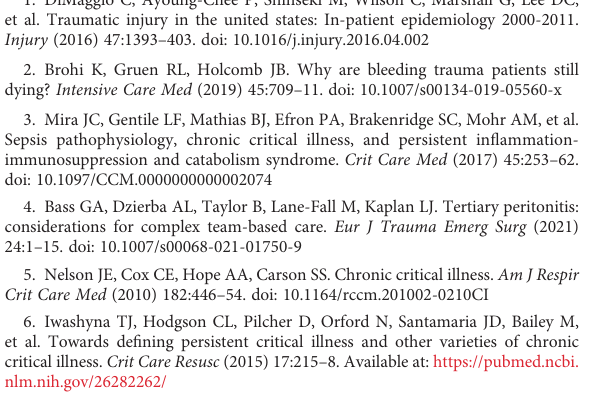
SUPPLEMENTARY FIGURE 2 Selection of model predictors using the least absolute shrinkage and selection operator (LASSO) logistic regression model combined with 10- fold cross-validation. ( A ) Selection of appropriate parameters ( l ) from the LASSO method by ten-fold cross-validation and minimum criteria. Binomial deviance curve was plotted against log ( l ). Dotted vertical lines were drawn at the optimal values by the minimum criteria and the one standard error of the minimum criteria; ( B ) LASSO coef fi cient pro fi les of all variables. Coef fi cient curve was plotted against the log lambda sequence. A vertical line was presented at the value. SUPPLEMENTARY FIGURE 3 Correlation matrix for model predictors. Panels in the lower left show scatted diagrams between the eight model predictors, and smooth lines (red) were fi tted. Panels in the upper right show correlation coef fi cients between the eight predictors. Panels in the diagonal line show histograms of each predictor. * indicates P<0.05, ** indicates P<0.01, *** indicates P<0.001.